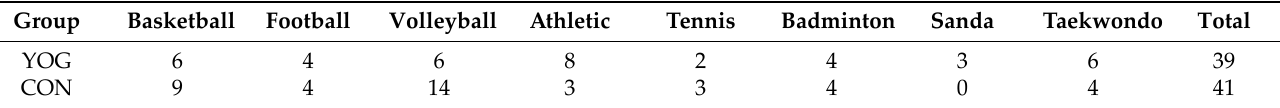
Table 2. Sport‑specific information sheet.